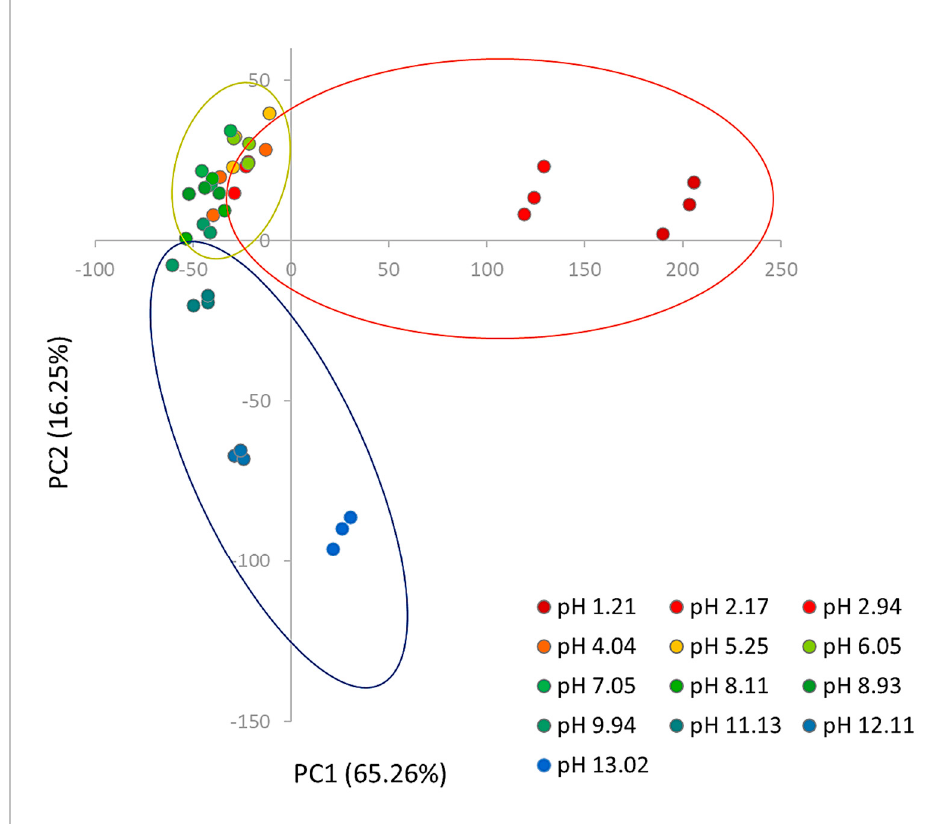
Figure 5. The score plot of the PCA model on the first two principal components. The ellipsoids are added to identify the clusters at the different pH subintervals and later used for building the PLS models.